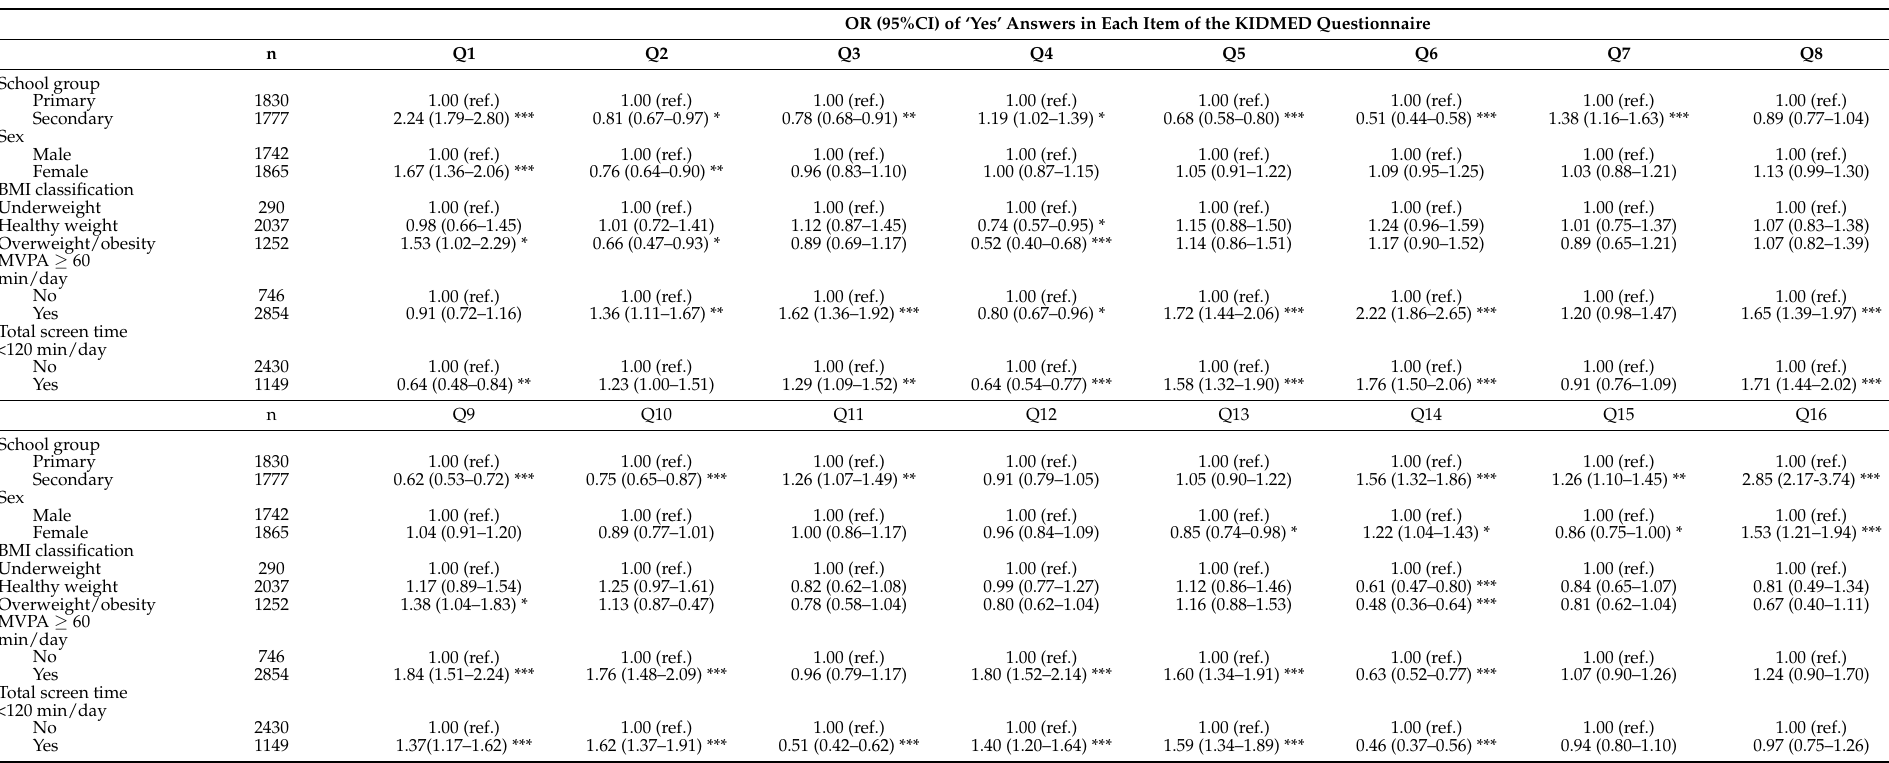
Table 5. Odds ratios (and 95% confidence intervals) from logistic regression showing the association of child/adolescent characteristics with child/adolescent ‘yes’ answers in the KIDMED